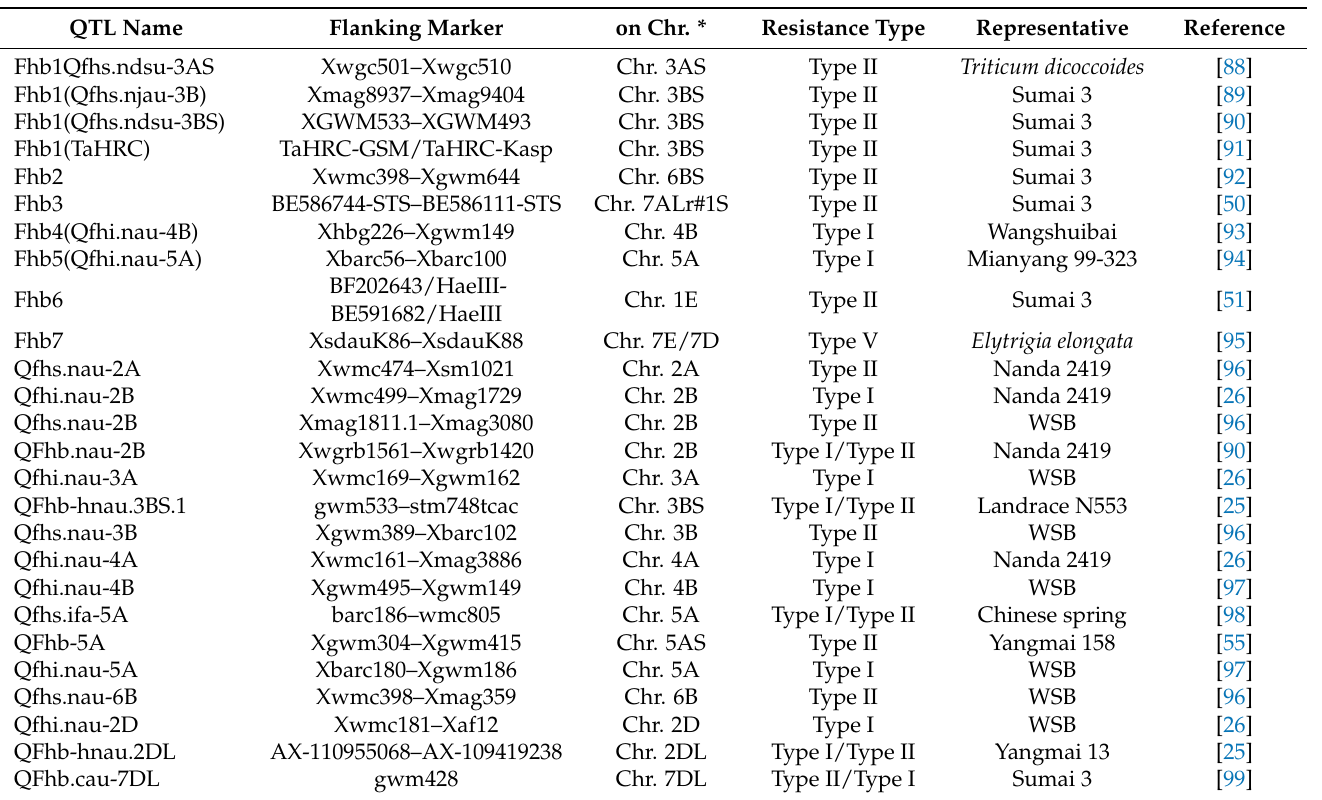
Table 1. Information on the resistance QTLs to FHB in